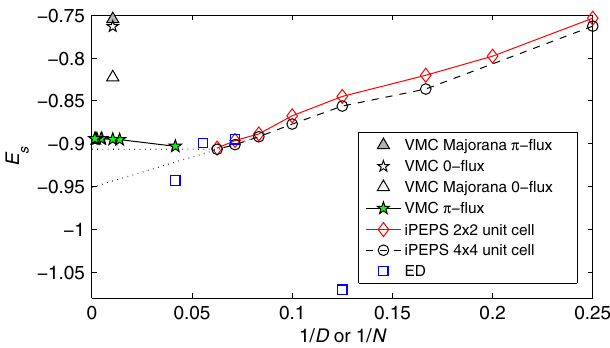
FIG. 2. Energy per site as a function of inverse bond dimension D (iPEPS) and as a function of inverse system size N (VMC and ED). We note that the LFWT energy ( E s ¼ (cid:3) 1 : 5 , not shown) is not Fig. 2 the ground-state energies of the various approaches.